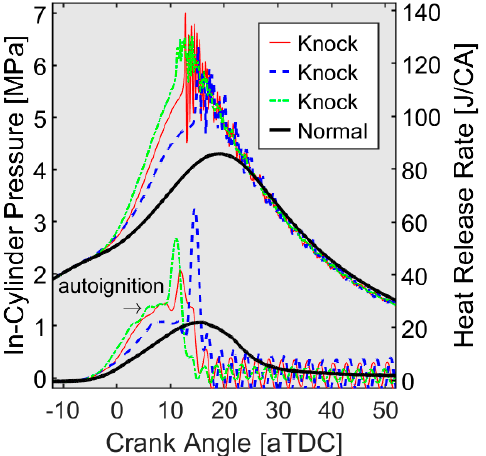
Figure 5. In-cylinder pressure and apparent heat release traces of three knock cycles.